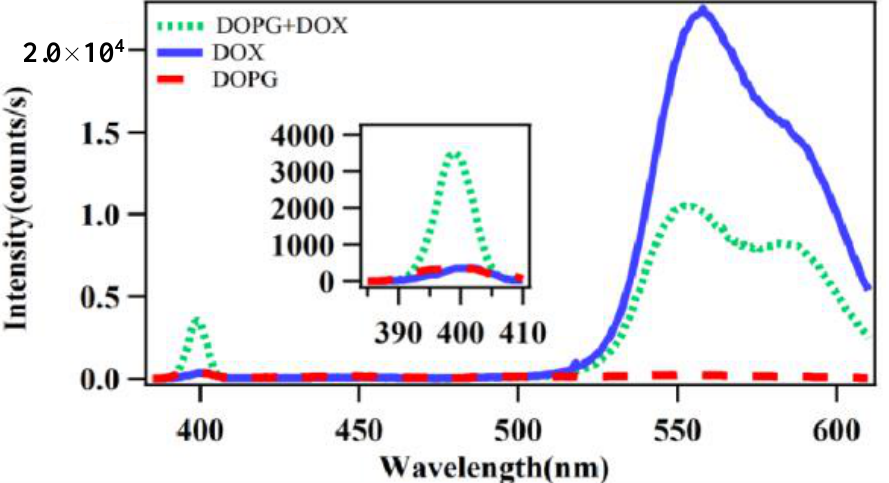
Figure 2. Scattered spectra from DOX solution (10 µ M, solid line), DOPG vesicle solution (250 µ M, dashed line), and the mixture of them at their respective concentrations (dotted line) with excitation by an 800 nm laser. Reproduced with permission [57]. Copyright 2019 American Chemical Society.